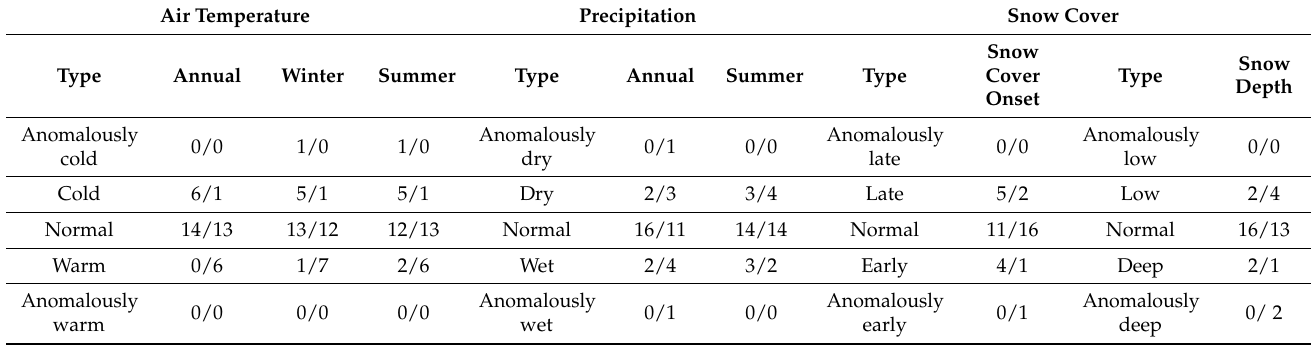
Table 3. Number of years and seasons by air temperature, precipitation, and snow cover types in the 20-year periods 1980/81–1999/00 (numerator) and 2000/01–2019/20 (denominator) based on Yakutsk Station